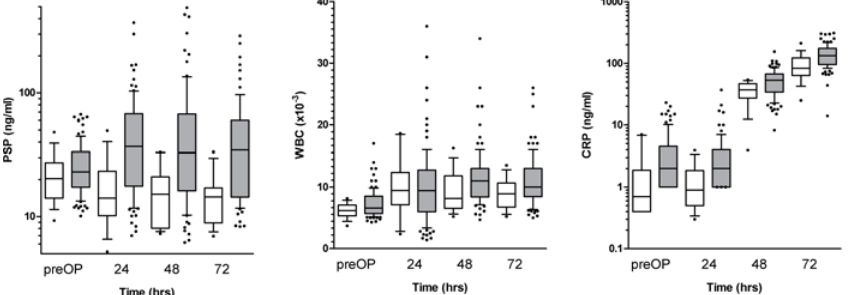
Fig 5. Time course of biomarkers as related to the surgical technique employed. PSP levels showed a significantly steeper rise in the postoperative course of patients subjected to sternotomy compared to those receiving minimally invasive surgery (p < 0.05 for interaction, determined by a linear mixed effects regression model). There was no significant difference in the postoperative levels of CRP and WBC between the two cohorts of patients.